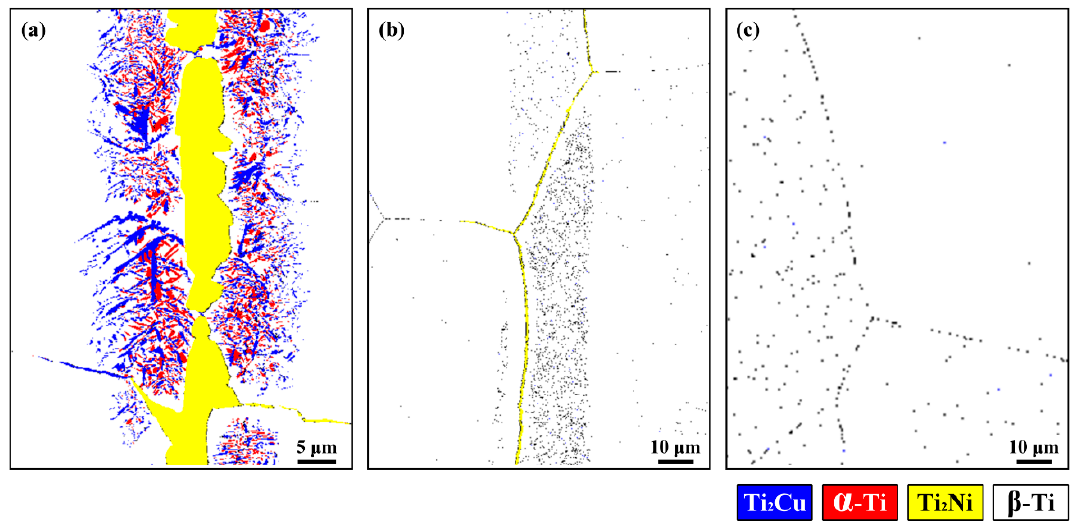
Figure 8. EBSD phase maps of ( a ) B3 joint in Figure 6a; ( b ) B10 joint in Figure 4b; ( c ) B10 joint in Figure 4c.